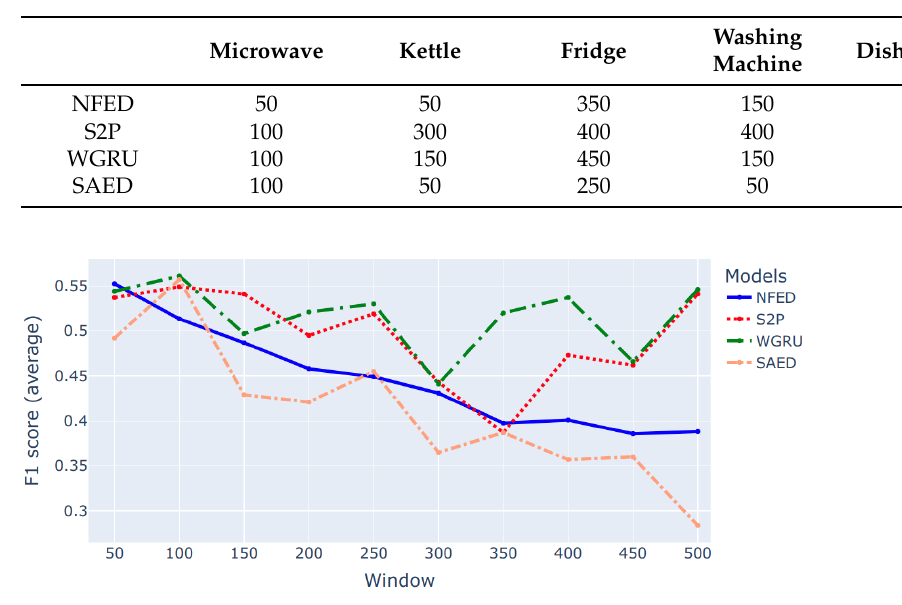
Figure 1. An example of how the performance of various models is affected by the input length. The target appliance is a washing machine and the evaluation metric is F1